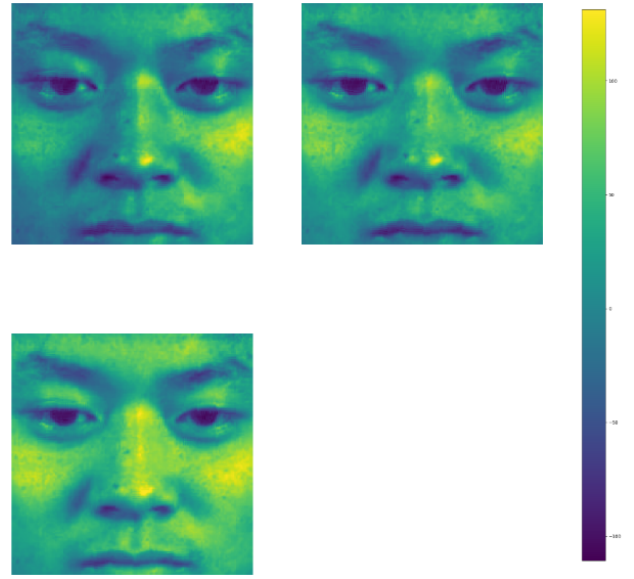
Figure 7. A close look at feature learning from a